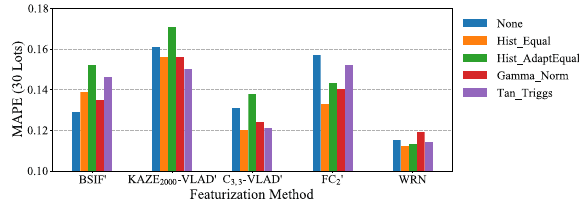
Fig. 7 Average performances of the ML models with different intensity normalization routines. Prime superscript denotes that the model was trained and evaluated on the 6000-image reduced dataset. No prime superscript means the model was trained and evaluated on the full